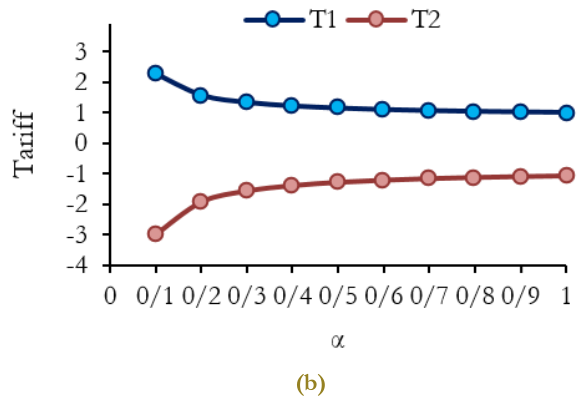
Fig. 6. The impact of α on the tariff (tax or subsidy) set by the government: (a). λ = 0 ; (b). λ = 1.